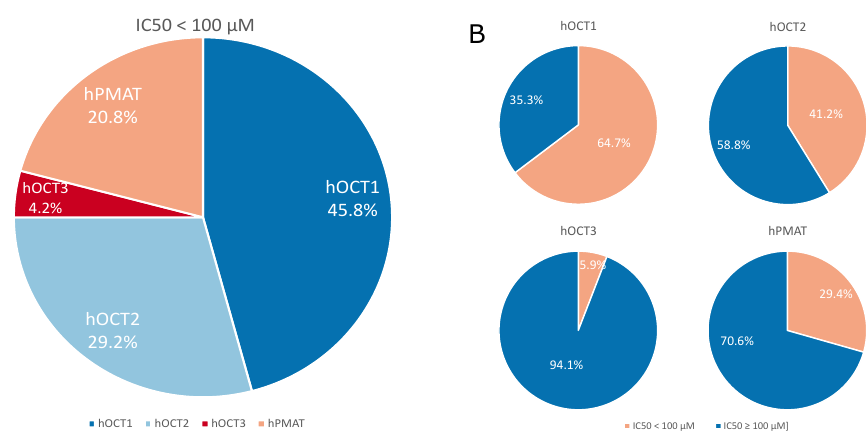
Figure 1. Graphical representation of the percentage of screened compounds inhibiting the substrate uptake of the transporters of interest with an half-maximal inhibitory concentration ( IC 50 ) below 100 µ M. ( A ): 45.8% of compounds inhibit hOCT1 (dark blue), 29.2% inhibit hOCT2 (light blue), 20.8% hPMAT (orange) and 4.2% inhibit hOCT3 (red). ( B ): 11 out of 17 compounds inhibit hOCT1, 7 compounds inhibit hOCT2, 1 compound inhibit hOCT3 and 5 compounds inhibit hPMAT.